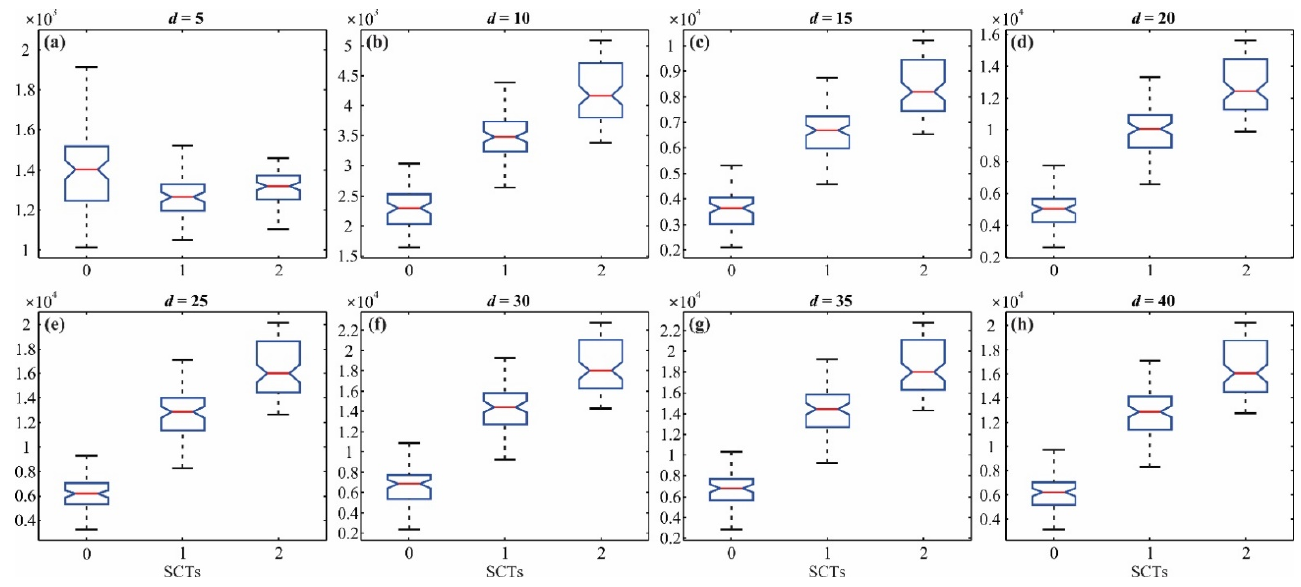
Figure 8. Unser contrast clusters for different values of d: ( a ) d = 5, ( b ) d = 10, ( c ) d = 15; ( d ) d = 20, ( e ) d = 25, ( f ) d = 30, ( g ) d = 35, and ( h ) d = 40.